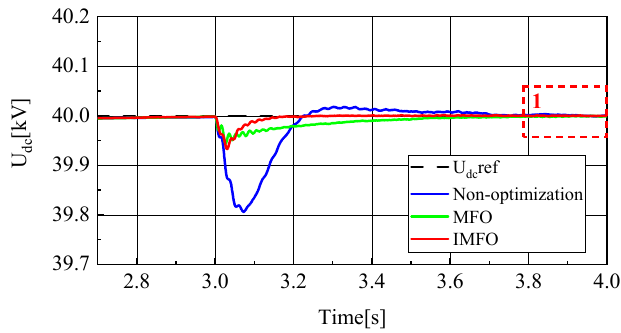
Figure 8. DC side voltage waveform.